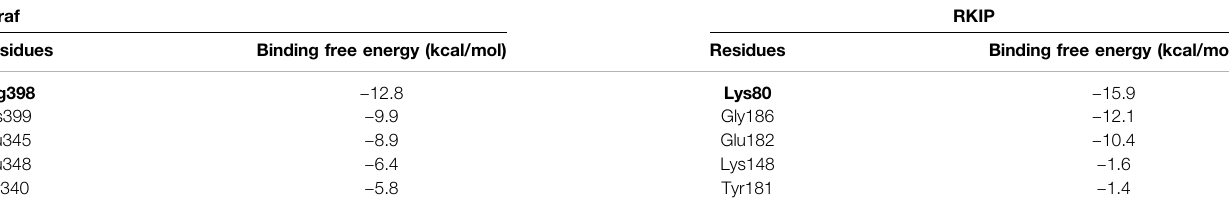
*Majorly contributing residues highlighted in